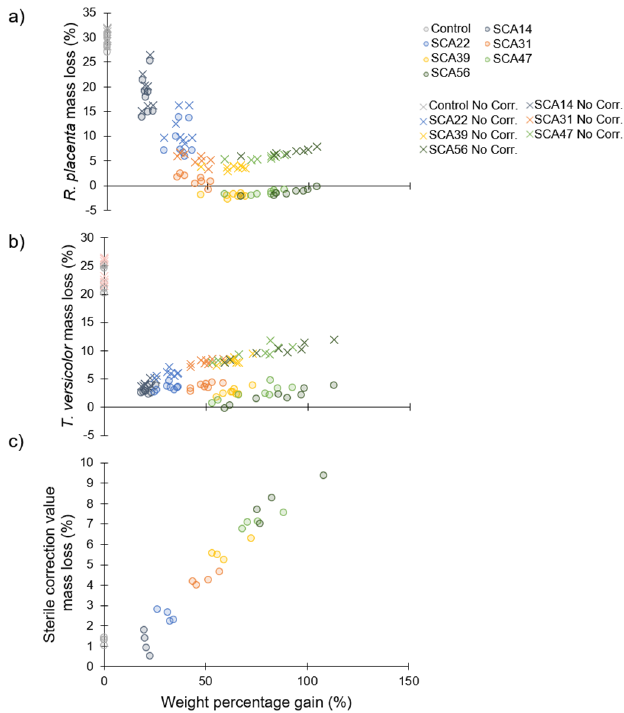
Figure 6. Mass loss of sorbitol citric acid modified wood as a function of weight percentage gain after eight weeks of exposure in modified EN 113 experiment. ( a ) Incubation with Rhodonia placenta ; ( b ) Incubation with Trametes versicolor ; ( c ) Sterile samples incubated without fungus used as correction values. Corrected mass loss values in ( a , b ) are shown with circles while uncorrected values are shown with exes.